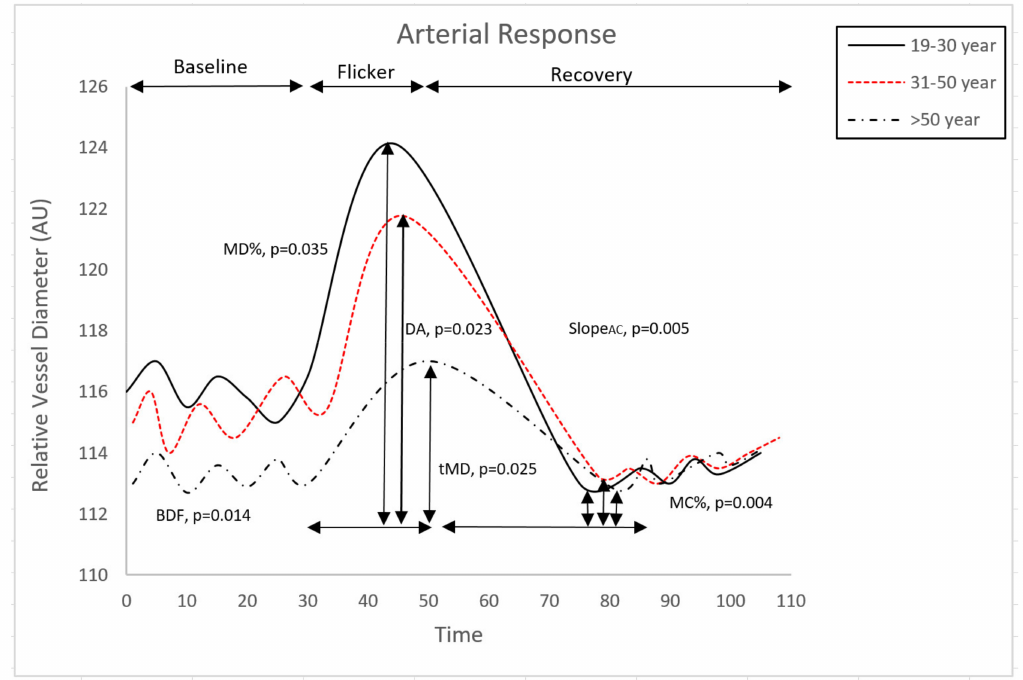
Figure 3. Comparison of retinal arterial response profile across groups. Abbreviations: AU, arbitrary units; BDF, baseline diameter fluctuation calculated as the maximum range in vessel diameter during first 30 s of baseline readings; MD%, percent dilation calculated as the percentage change in vessel diameter from baseline to maximum following onset of flicker; tMD, time to reach maximum diameter during flicker; slope AC , slope of arterial constriction calculated as (MC-MD)/(tMC); DA, dilation amplitude (difference between MD and MC during flicker); MC%, percent constriction calculated as the percentage change in vessel diameter from baseline to maximum following end of